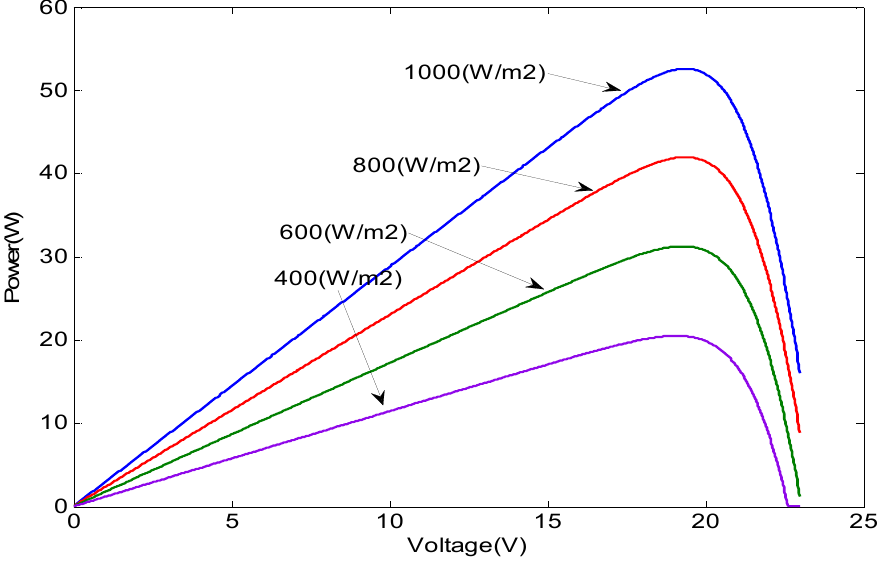
Figure 8. The output characteristics of the PV array.